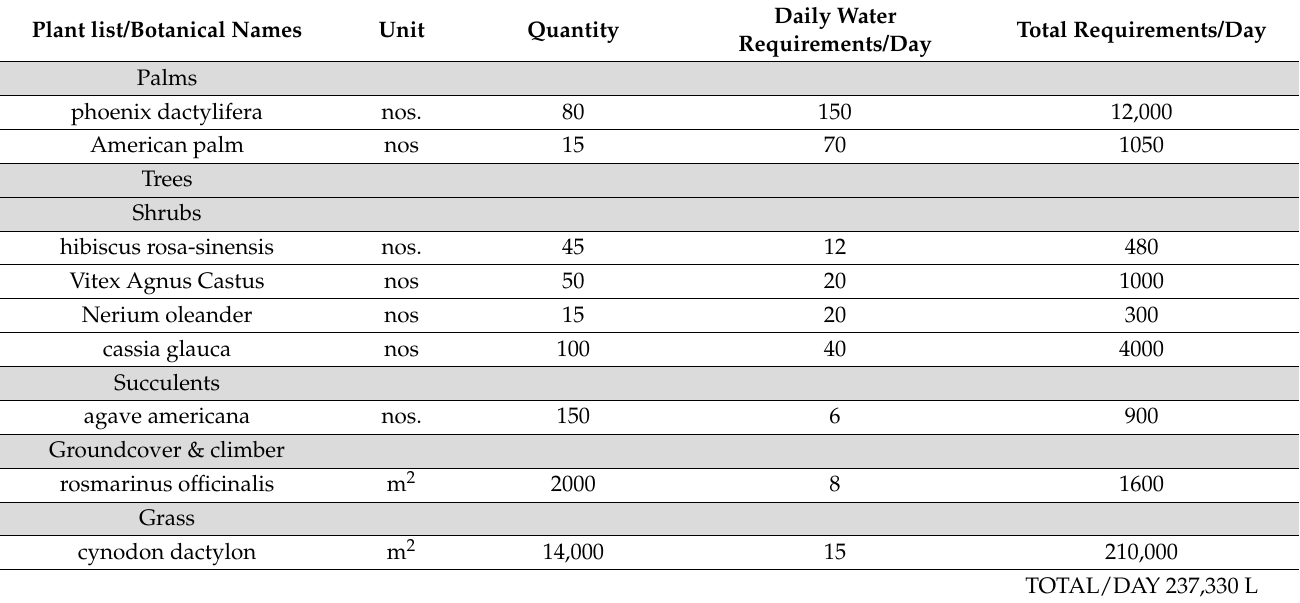
Table A4. Water consumption for each softscape item: previous situation for WALKWAY landscape